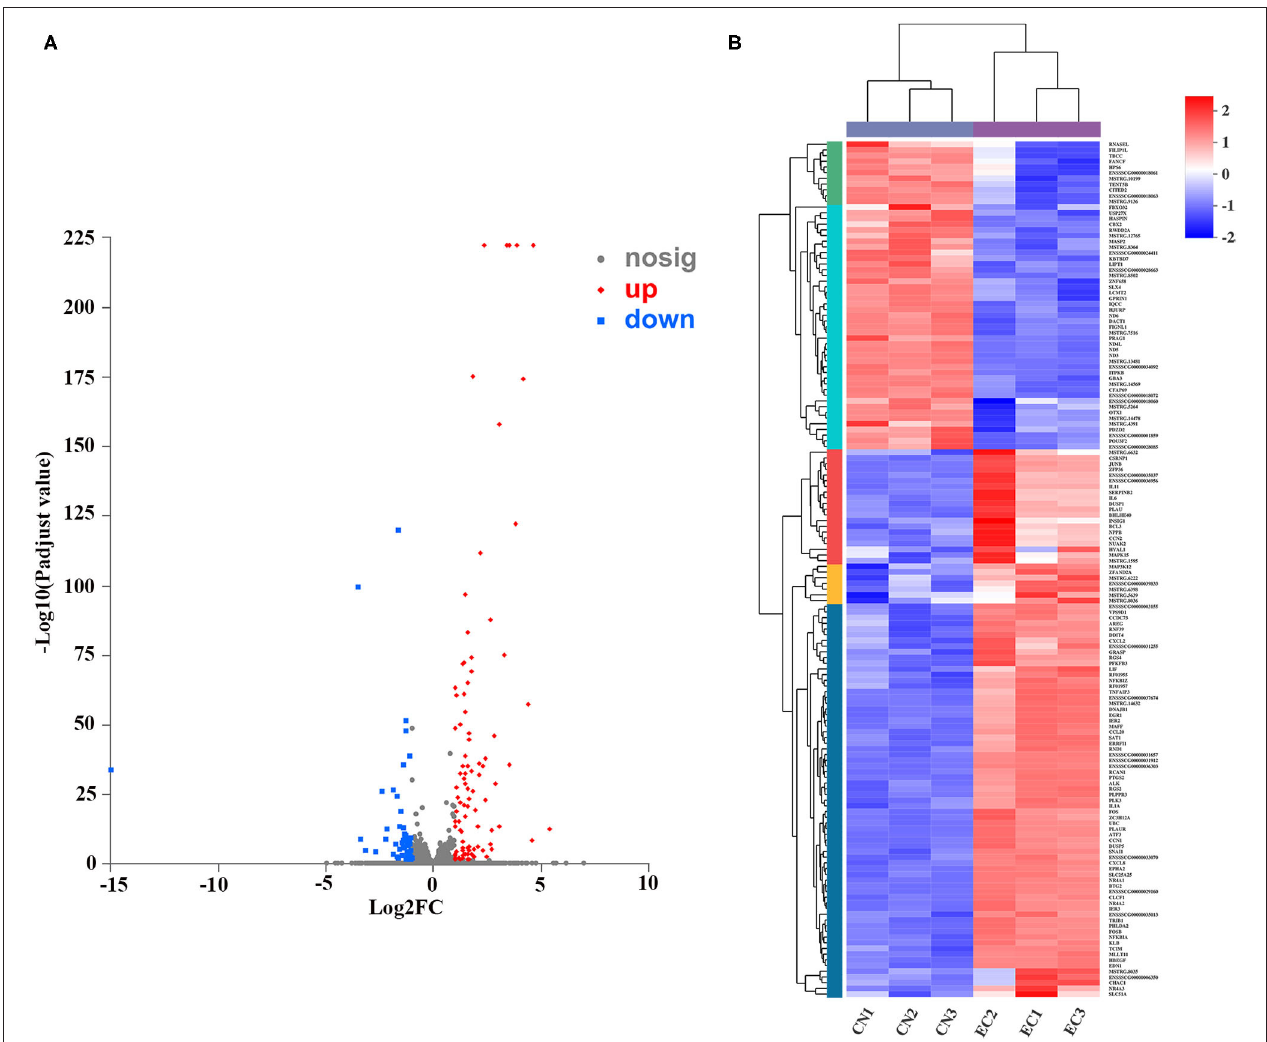
FIGURE 4 | Identification and expression of DEGs. (A) Volcano plot of DEGs between CN and EC groups. X-axis represented fold change of expression of DEGs, and Y-axis represented statistical significance of fold change. Each point represented a DEG. Red dots represented significantly upregulated DEGs; blue dots represented significantly downregulated genes; gray dots represented insignificantly DEGs. (B) Cluster heatmap of DEGs. Rows and columns represented genes and samples. Legend represented Log 2 FC of gene abundance. Red and blue indicated high and low expression of DEGs,